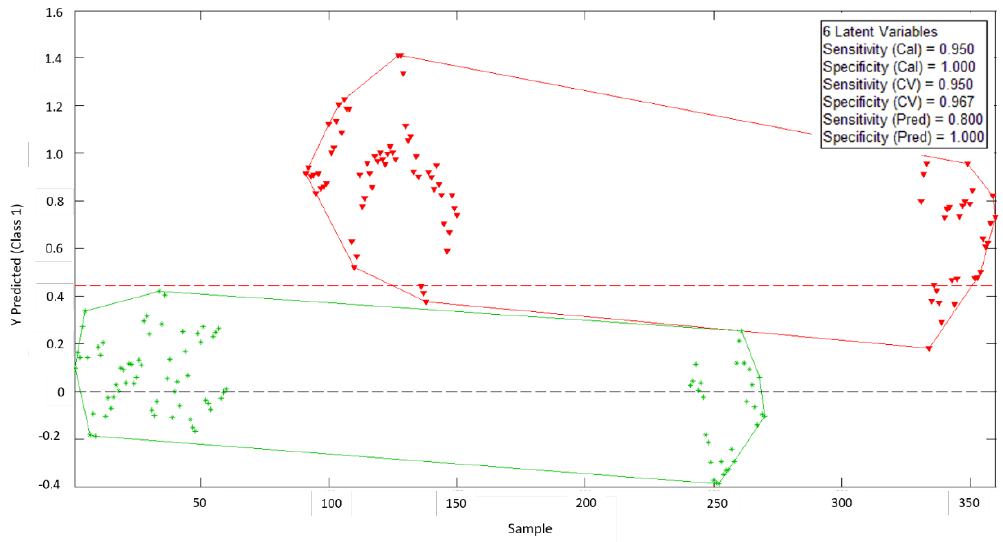
Figure 5. Partial least squares discriminant analysis (PLS-DA) biplot for EIS raw data from the analyzed orange samples: green crosses represent natural (i.e., unfrozen) samples, and red triangles represent those having experienced a freeze phenomenon.